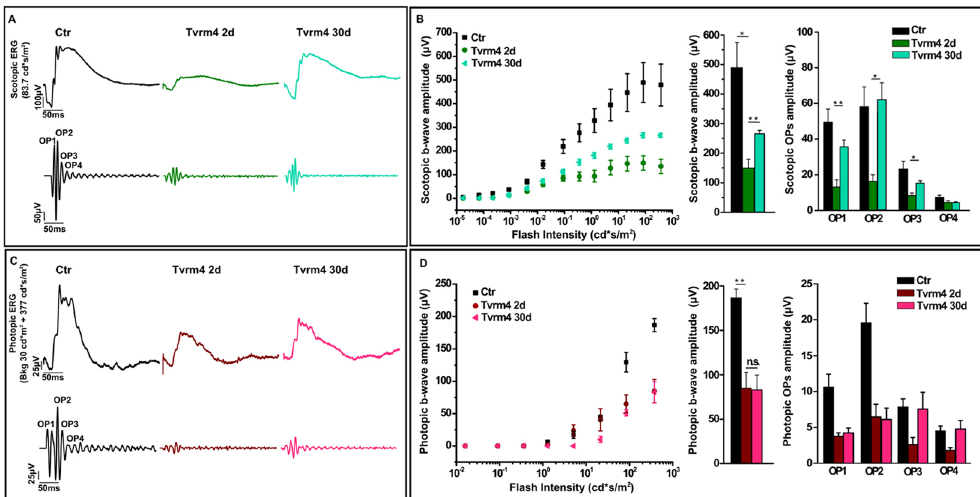
Figure 8. Recovery of retinal function 30 days post exposure. ( A ) Top traces: Representative scotopic flash ERG responses. Bottom traces: OPs filtered from the ERG response to the bright flash. ( B ) Left panel: scotopic b-wave amplitude as a function of flash intensity. Middle histograms: maximum b-wave amplitude measured in response to 83.7 cd * s/m 2 from control and Tvrm4 mice exposed to 12,000 lux for 1 min and recorded 2 and 30 days after phenotype induction. Right panel: histograms of scotopic OPs amplitudes, showing a trend similar to the b-wave. ( C ) Top traces: representative photopic flash ERG responses. Bottom traces: OPs filtered from the ERG response to the brightest flash. ( D ) Left panel: photopic b-wave amplitude as a function of flash intensity. Middle histograms: maximum b-wave amplitude measured in response to 377 cd * s/m 2 . Right panel: histograms of photopic OPs amplitudes. N = 6 for each condition. Bars represent the mean ± SE * P < 0.05; ** P < 0.01 one- way